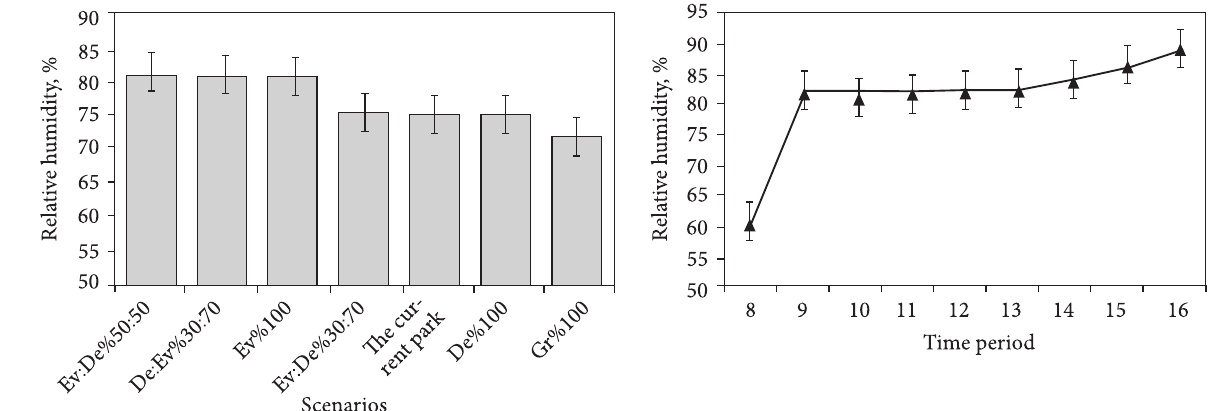
Figure 5. Comparison of RH in the various simulated scenarios and in the period time